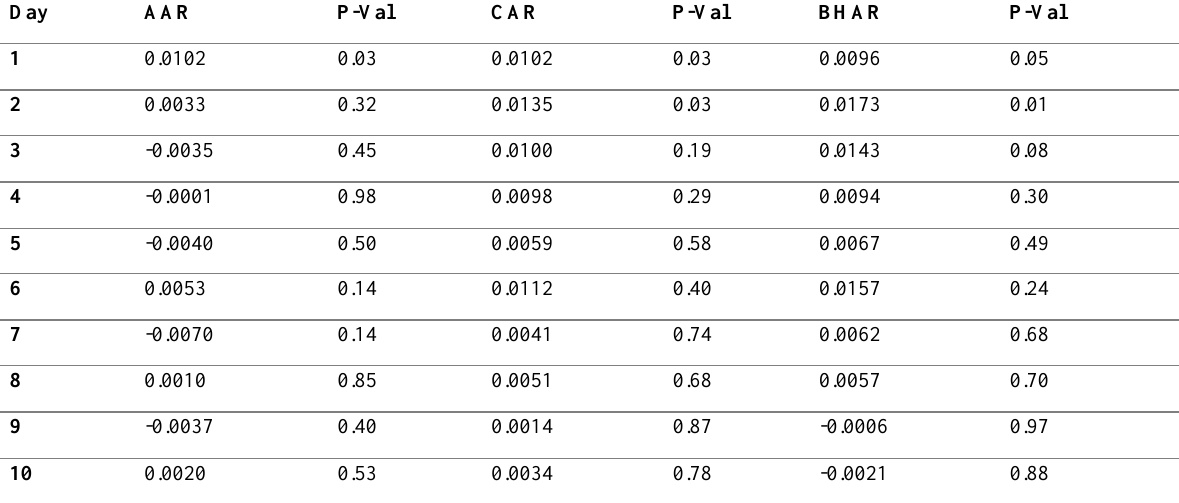
Table 2: The Effect of Positive Earnings Announcement on Stocks